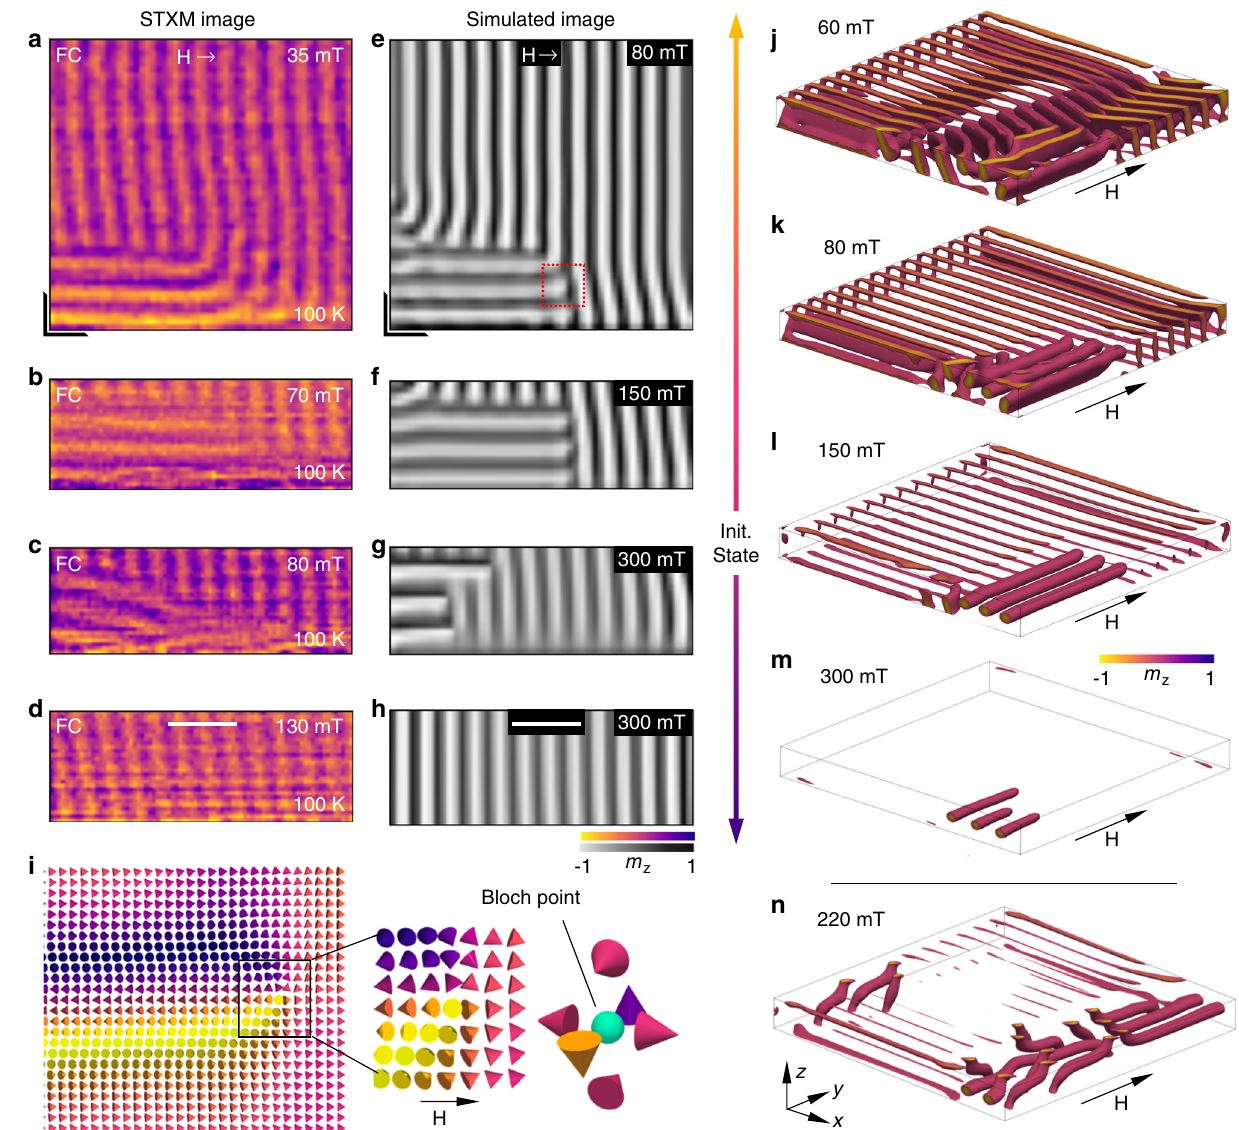
Fig. 4 Experimental observation and micromagnetic simulations of skyrmion tubes. a – d Scanning transmission x-ray micrographs of the skyrmion tube spin texture embedded in the conical state observed as a function of applied in-plane magnetic fi eld. The colourmap plots the normalised out-of-plane magnetisation averaged through the thickness of the sample, m z . The black L-shape in a indicates the location of the corner of the sample. e – h Simulated images of the skyrmion tube spin texture embedded in the conical state, as determined from micromagnetic simulations calculated as a function of applied in-plane magnetic fi eld, where the colourmap plots the normalised out-of-plane magnetisation averaged through the thickness. i A cross section of spins from the simulation in e , location shown by the red box, highlighting the presence of a magnetic Bloch point at the end of each skyrmion tube. j – m Three dimensional visualisations of the micromagentic simulations for selected magnetic fi elds, obtained by plotting cells with normalised m y between -1 and 0. n Three dimensional visualisation of the skyrmion tube state achieved after a fi eld sweep from an initially randomised state. Scale bars, 200